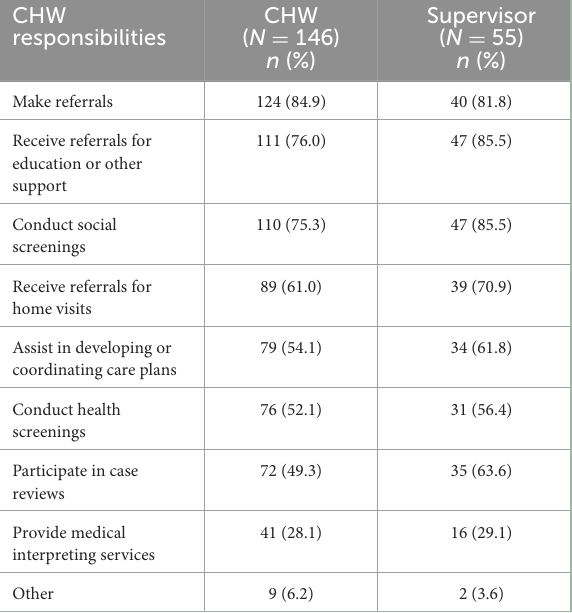
TABLE 4 Team structure and reporting methods among a national sample of CHWs and CHW supervisors working with Medicaid managed care organizations.